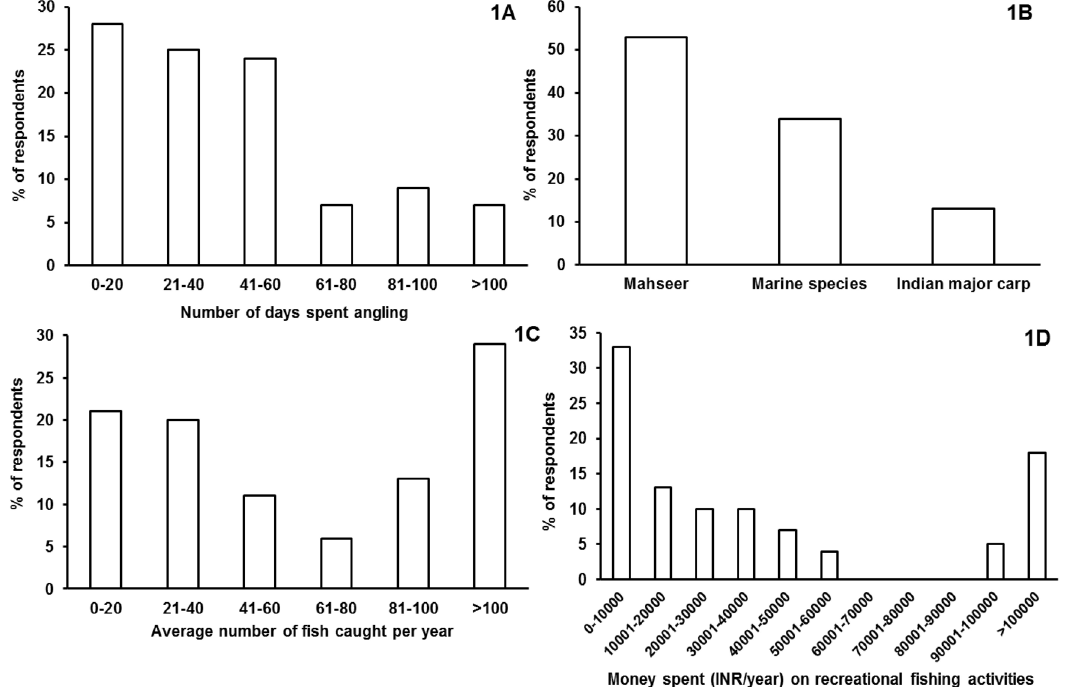
Figure 1. Distribution of responses to angling-species questions (1A: number of days spent angling; 1B: preferred angling fish species; 1C: average number of fish caught/year; 1D: money spent (INR/year) on recreational fishing activities).